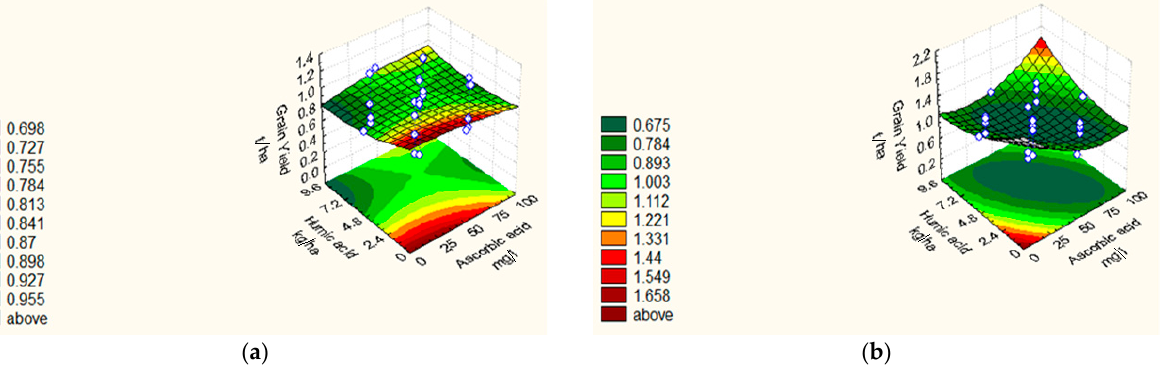
Figure 9. Response surface for grain yield in two seasons ( a ) in 2018/19 and ( b ) 2019/20, as affected by AA and HA at the central levels AA and HA.